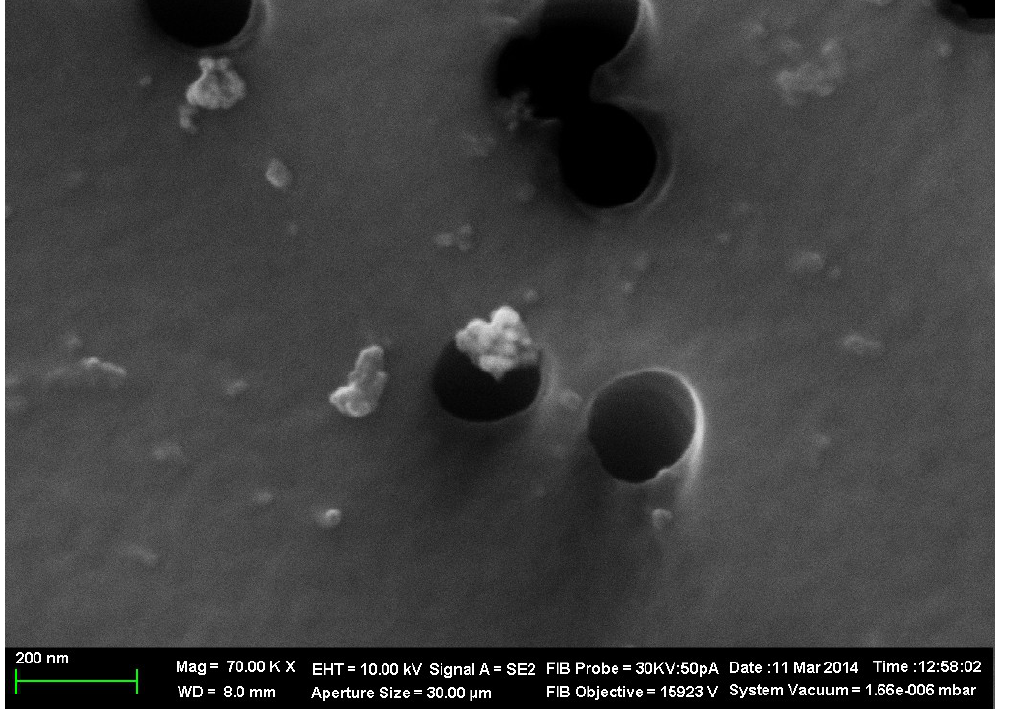
Figure 2. Percentage distribution of particles by size in the submicron range on filters through which the ambient air of a cathode copper smelting and casting facility had been drawn (obtained by a program measuring and counting 500 spherical particles). N—Number of particles of a given diameter; N —Total number of 0